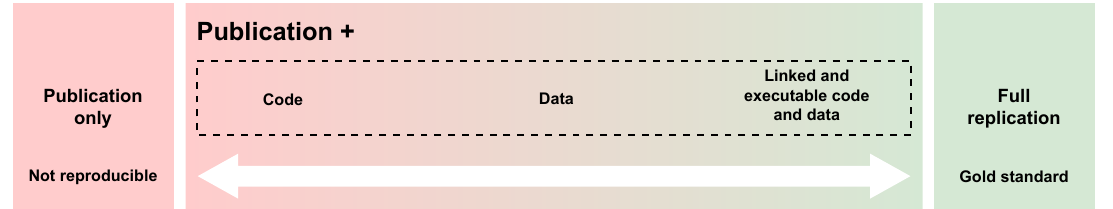
Figure 1. The spectrum of scientific reproducibility, between a scientific publication and full replication (based on